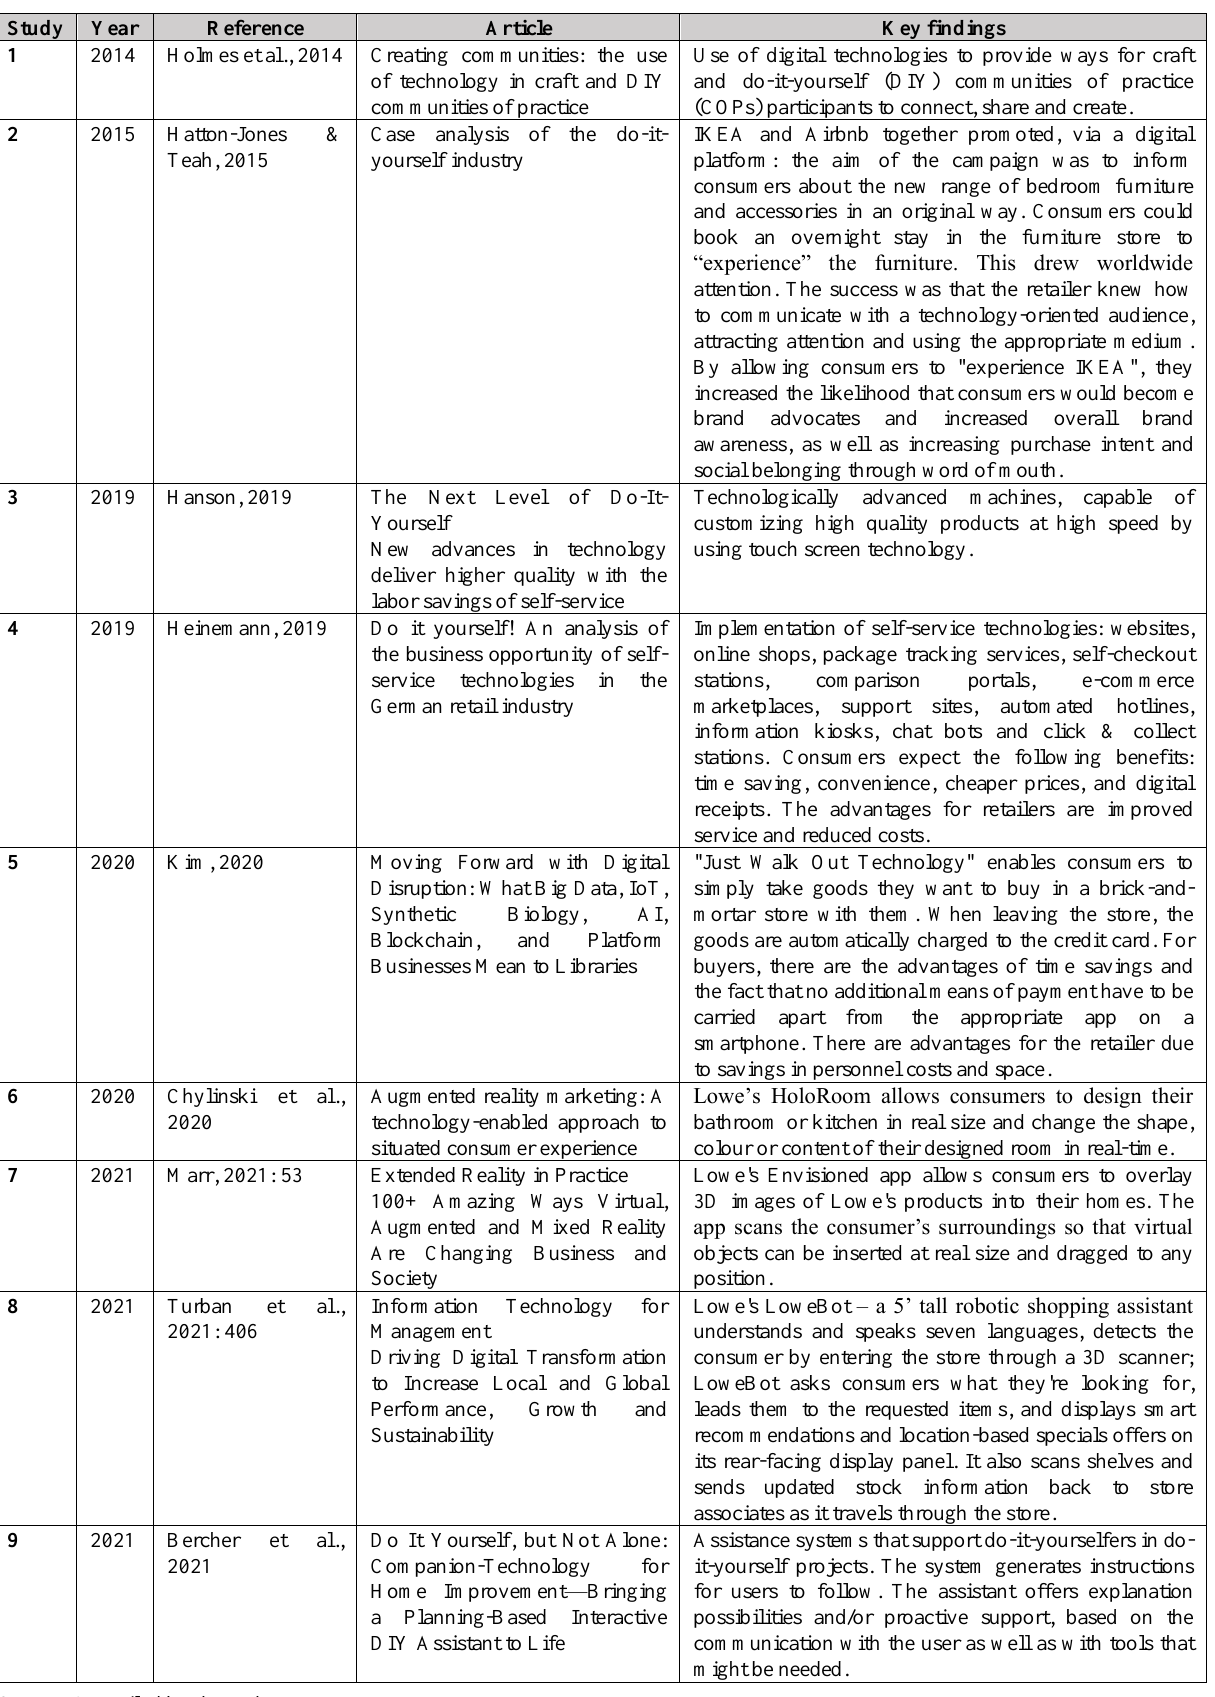
Table 4. Overview of the Key